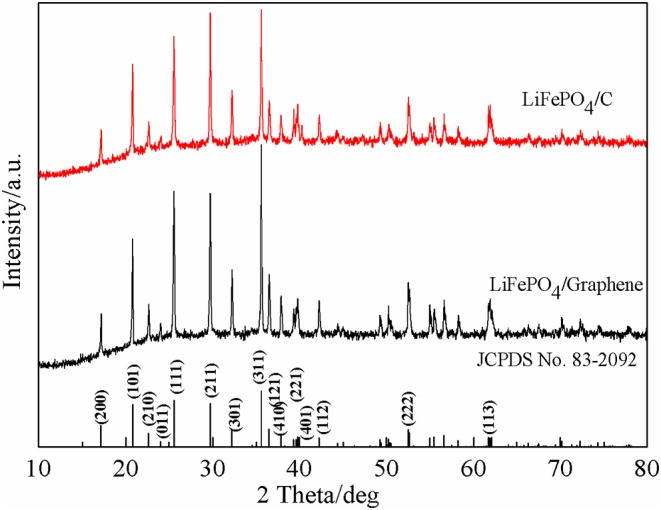
XRD patterns of the LiFePO4/graphene and LiFePO4/C composites.